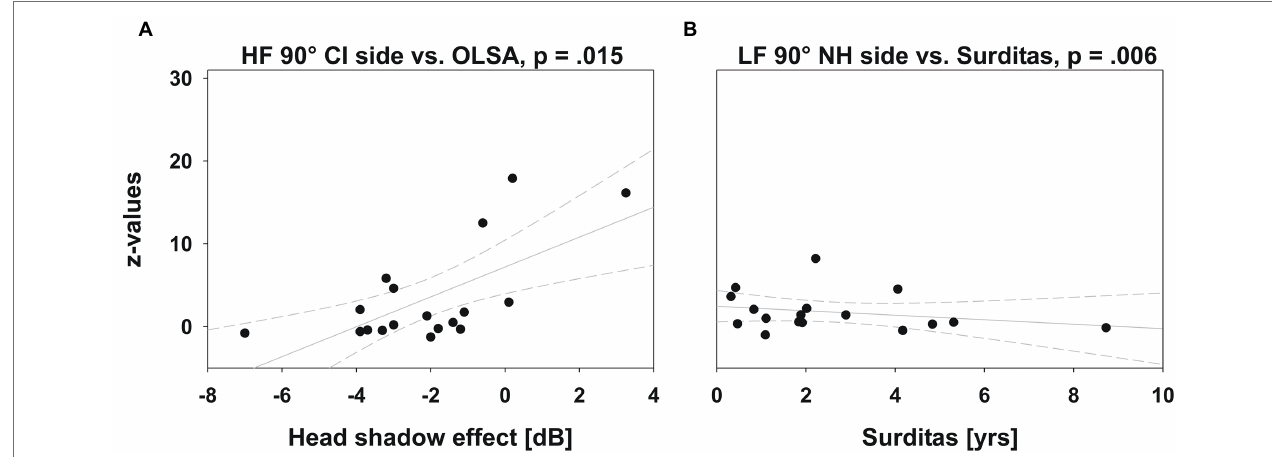
FIGURE 7 | Multiple regression. Localization ability ( z -values) plotted against head shadow effect (OLSA test) and duration of deafness. The gray solid line depicts the regression line and 95% CI (short-dashed lines). (A) The regression between OLSA test performance and localization ability was only significant at 90 ° on the CI side, where speech understanding in noise was also improved by the CI. Participants who localized sounds more accurately (lower z -scores) showed greater improvement in SRT due to the CI. (B) Although the ANOVA revealed a significant influence of the duration of deafness on the localization ability, the coefficients are not clinically relevant, as shown here for the regression with the lowest value of p